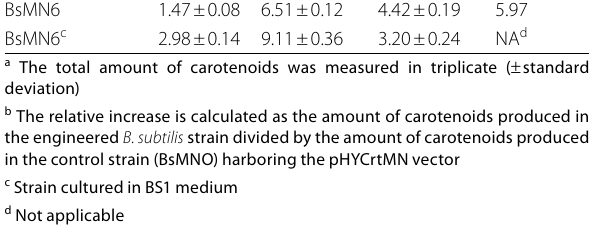
Fig. 2 Quantitative analysis of C 30 carotenoids produced by engineered B. subtilis strains. Samples were analyzed by HPLC after C 30 carotenoid extrac- tion with acetone. Quantification of each C 30 carotenoid was performed comparing peak areas with the standard reference curve, and then nor- malized to the dry cell mass of each culture. The amount of DNP is indi- cated in orange and the amount of DLP in yellow. The experiments were performed in